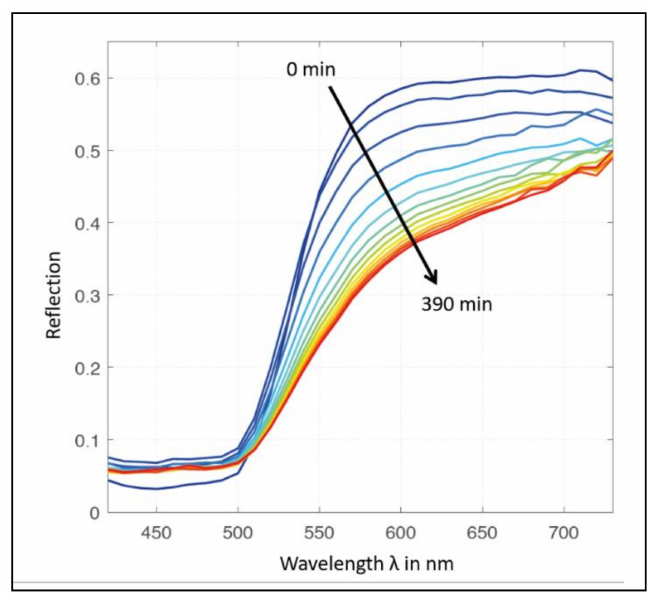
Figure 4. Spectra of mangoes during drying (0 min till 390